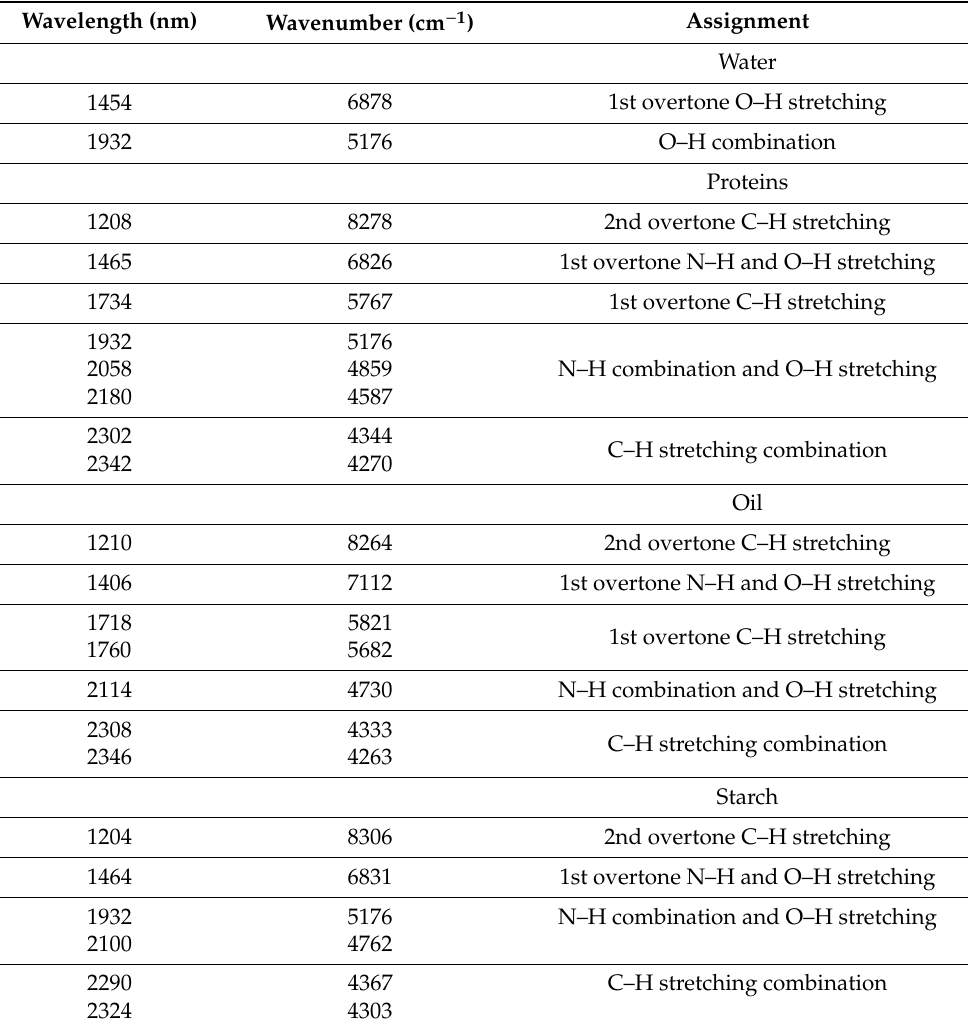
Table 1. Examples of NIR absorption bands